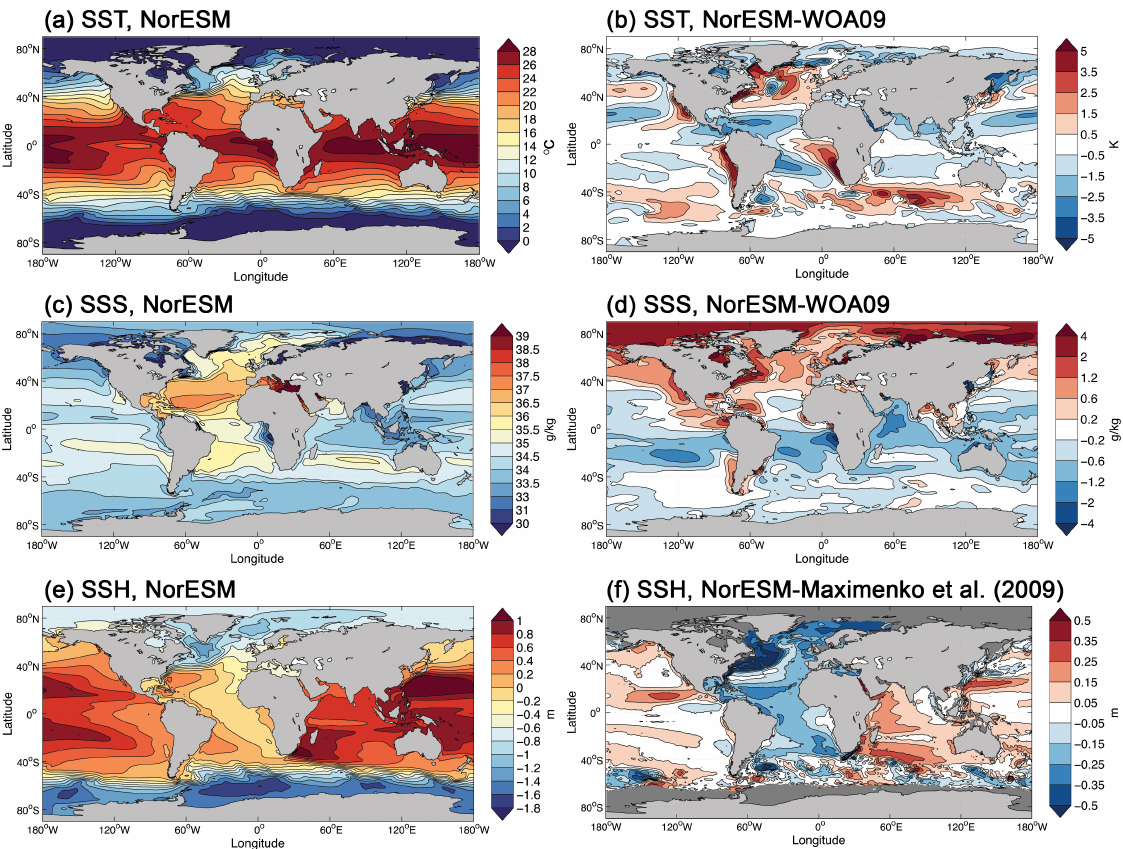
Fig. 12. (a) Mean simulated SST (K), (c) SSS (kgg − 1 ), and (e) SSH (m) for years 1976–2005 of Historical1. Right panels (b, d, f) show corresponding difference from observation-based data sets (model minus observation) where SST and SSS are obtained from WOA09 and SSH uses a 1992–2002 data set described in Maximenko et al. (2009). Areas with missing observations are shaded with dark grey colour, and the mean for the area with observed SSH of the simulated and observed SSH was subtracted from both data sets.